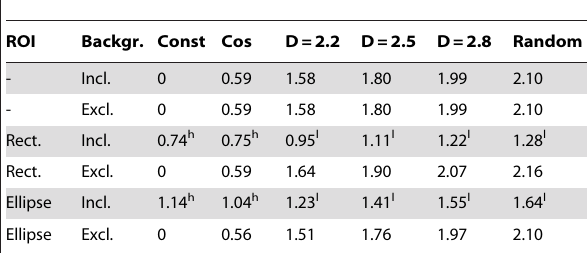
Table 2. ROI influences on Higuchi Dimension using every row and column extraction method